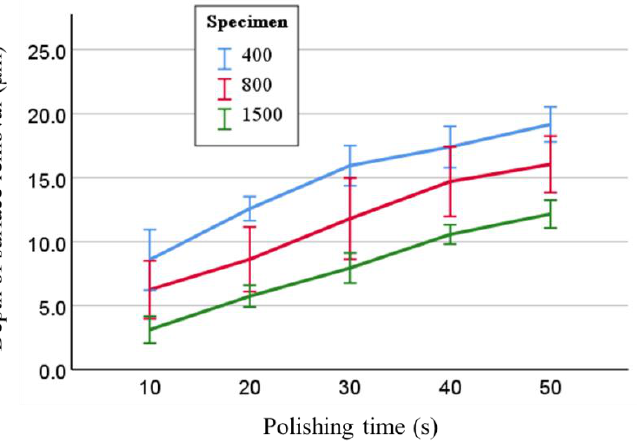
Figure 4. Mean depth of surface removal by polishing times and specimen types. Error bar indicates ±SD.